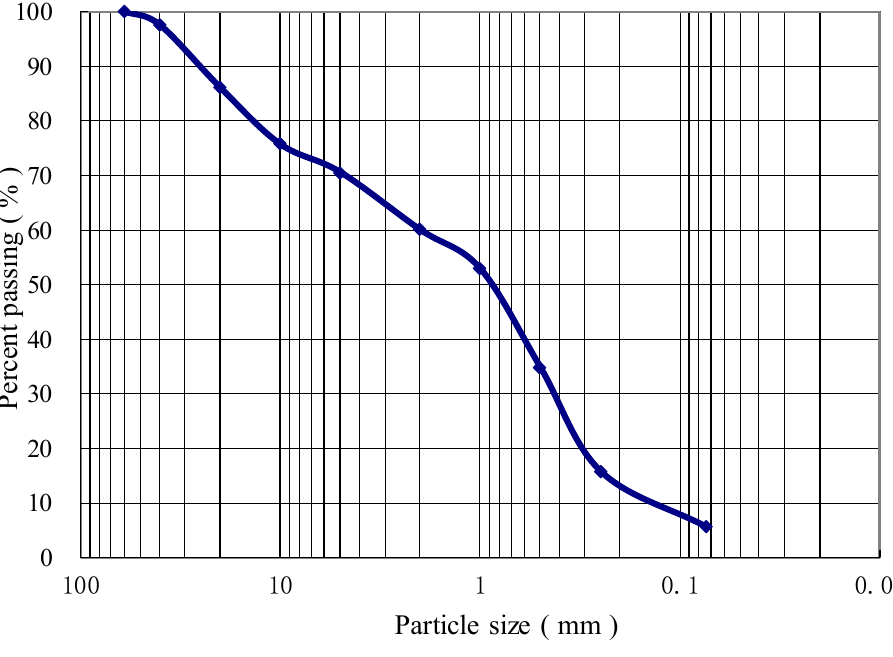
Figure 1. Particle size distribution curve.